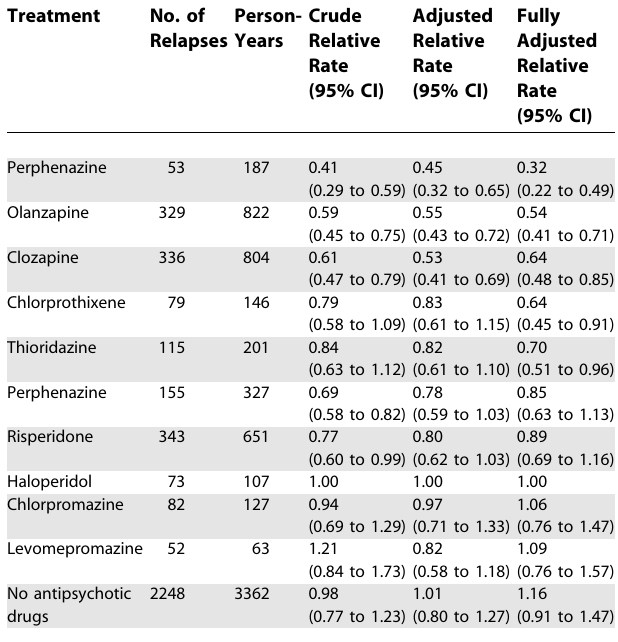
Table adapted from Tiihonen et al.